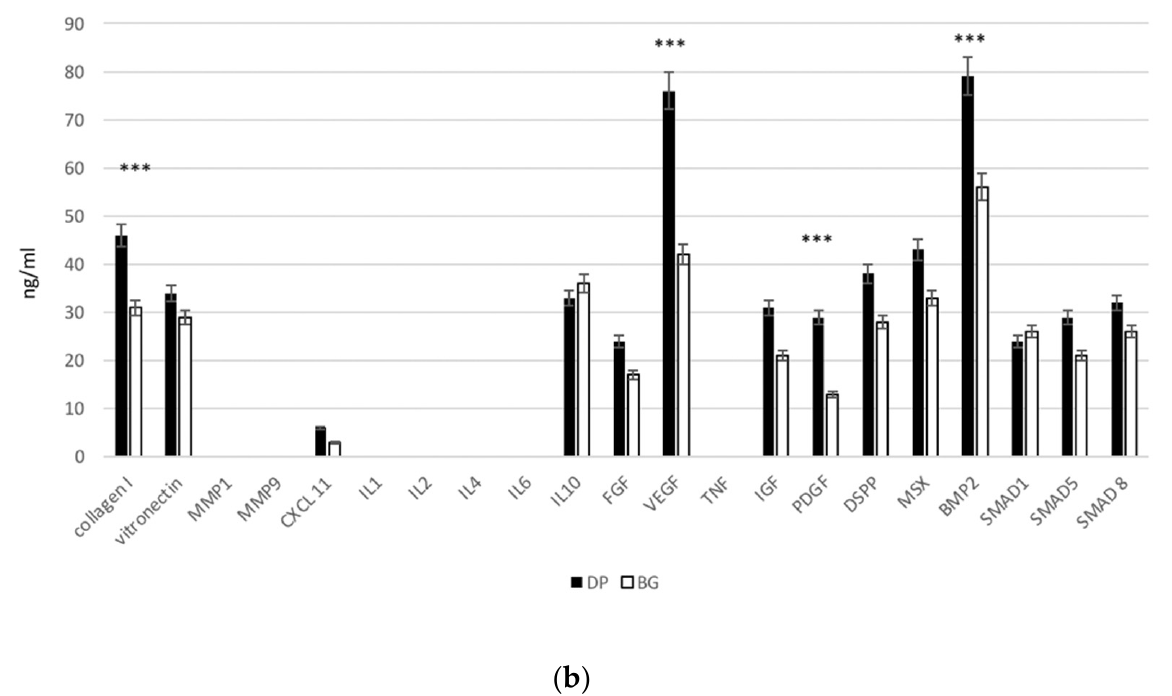
Figure 5. ( a ) Graphical representation of real-time PCR of mRNA related to genes for ECM and adhesion proteins of DPSCs cultured up to 21 days on DP (petrol blue bars) or BG (grey bars); ( b ) ELISA assay of proteins expressed by DPSCs cultured up to 21 days on DP (left) or BG (right). *** p < 0.001.